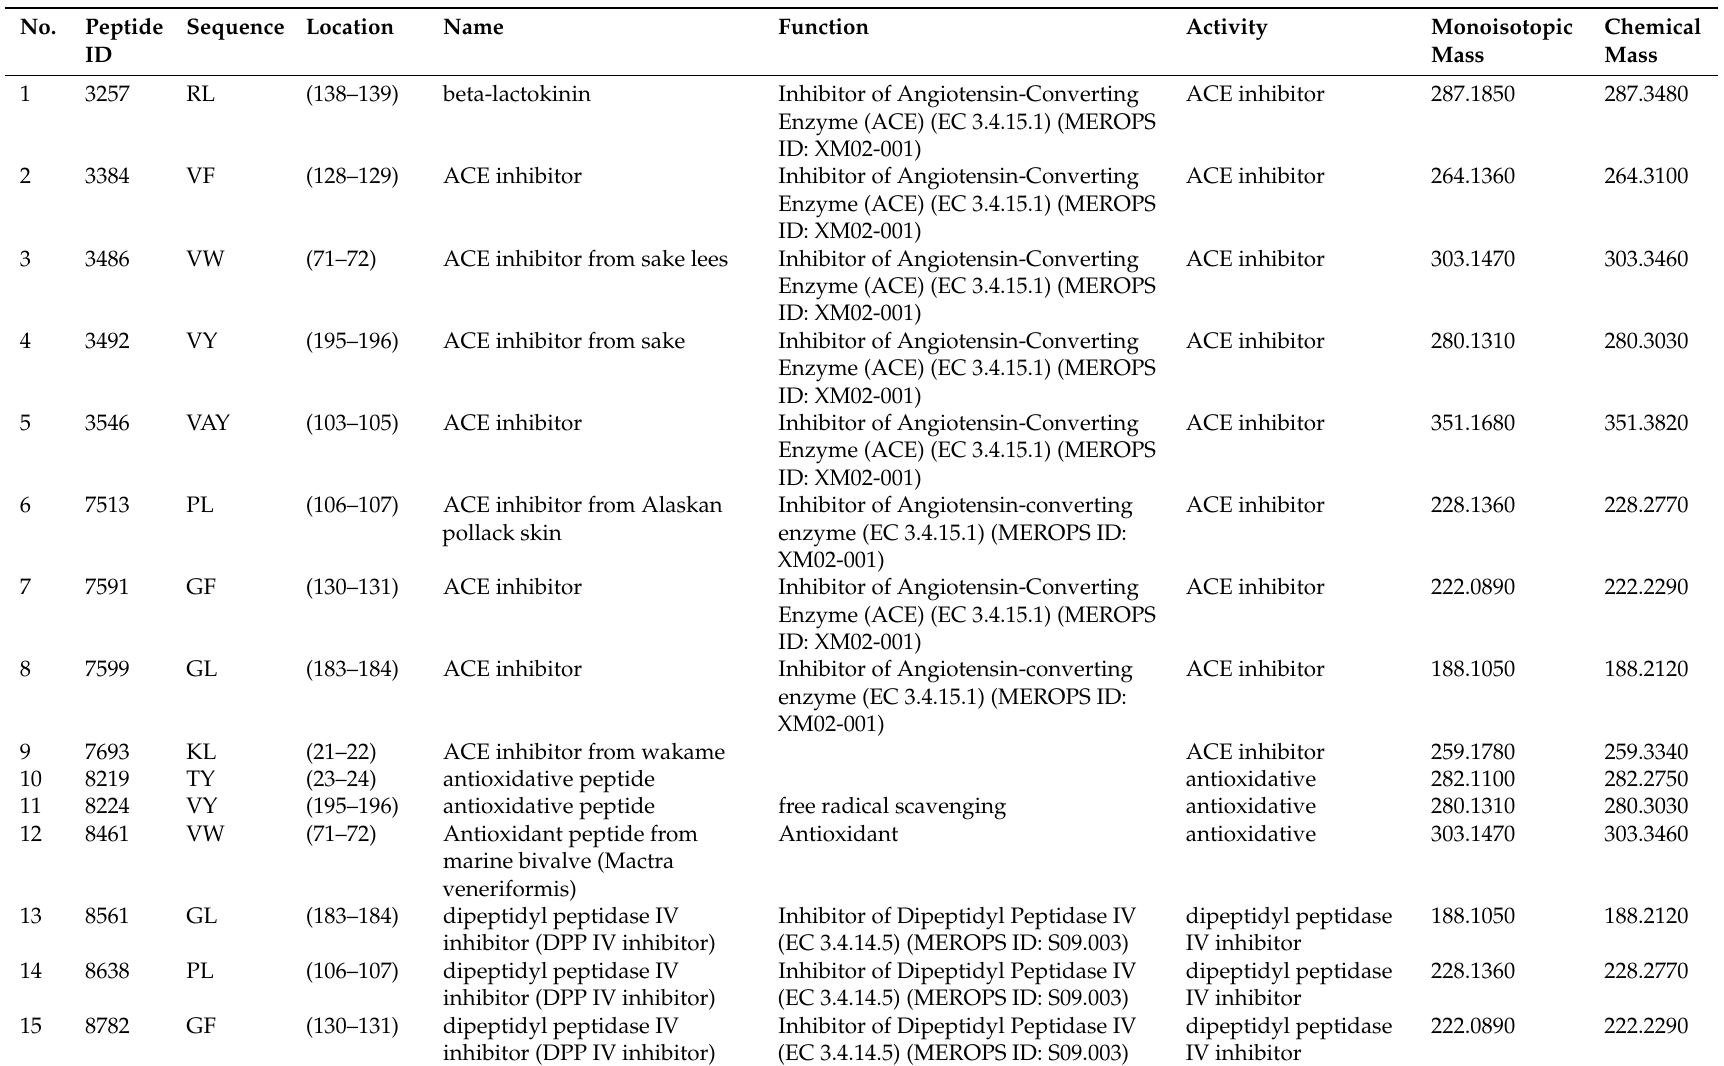
Table A53. Bioactive peptides from RubisCO of Halophila stipulacea . In silico enzymatic cleavage was carried out by using